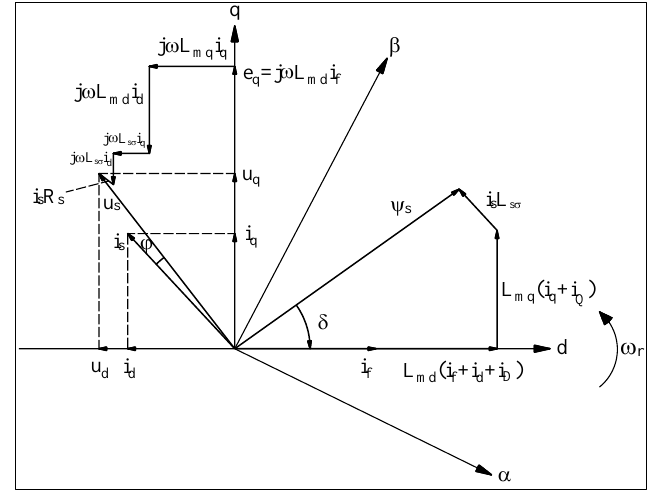
Figure 6. Vector diagram of the salient pole synchronous motor